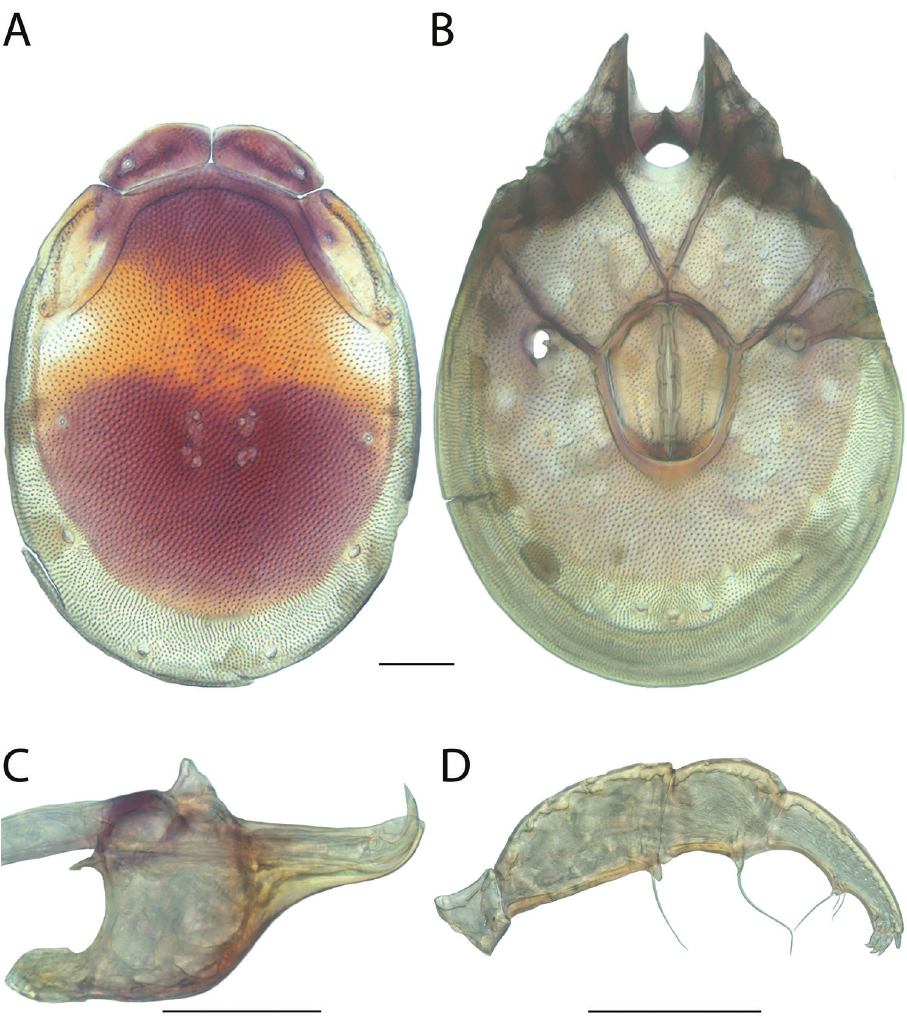
Figure 135. Torrenticola magnexa female: A dorsal plates B venter (legs removed) C subcapitulum D pe- dipalp (setae not accurately depicted). Scale = 100